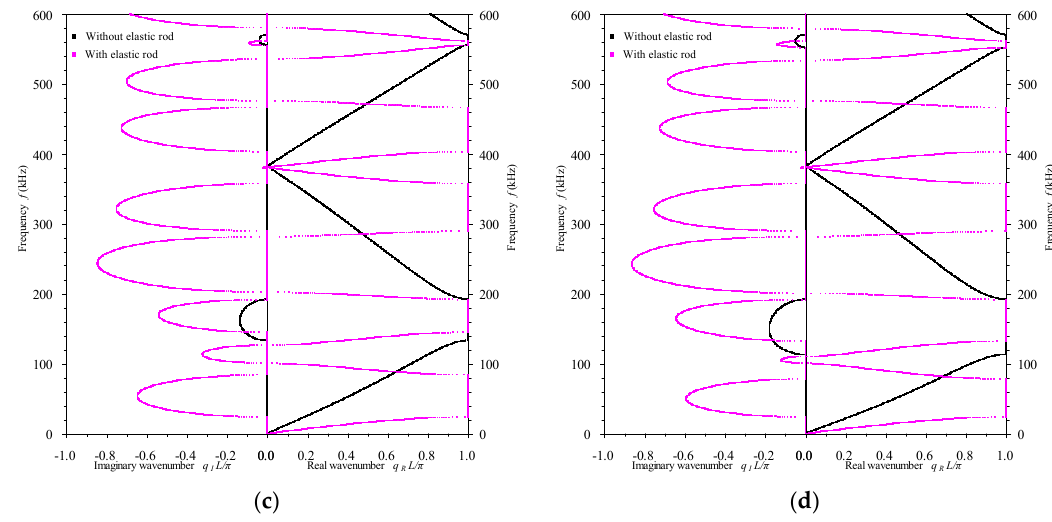
Figure 8. Influence of the elastic rod insert on the propagation constants spectra of the periodic PZT-5H piezoelectric rod covered by brass electrodes with periodic electrical boundaries: ( a ) electric-open condition; ( b ) applied electric capacity condition with C “ α A { l “ 1.02 ˆ 10 ´ 12 F; ( c ) electric-short condition; and ( d ) applied feedback control condition with K g “ 5 ˆ 10 8 V {